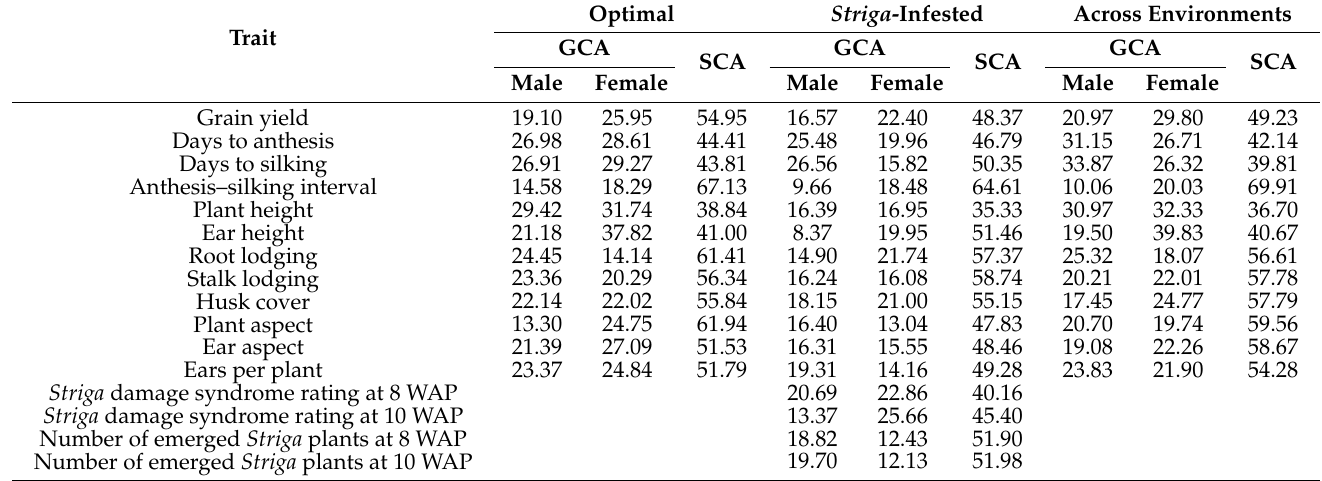
Table 4. Proportion (%) of the sum of squares for crosses attributable to the general combining ability (GCA) and specific combining ability (SCA) for grain yield and other phenotypic traits of early maturing inbred lines under optimal environments, Striga -infested environments, and across environments in 2016 and